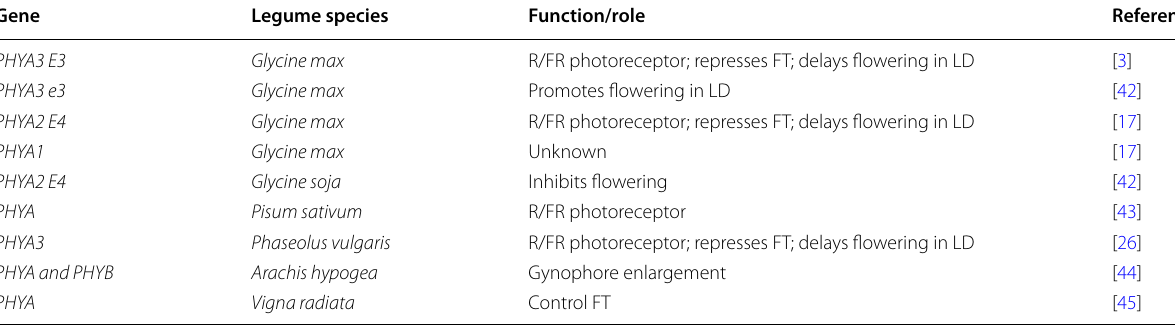
Table 3 Summary of identified Phytochrome A genes in different crop legumes Gene Legume species